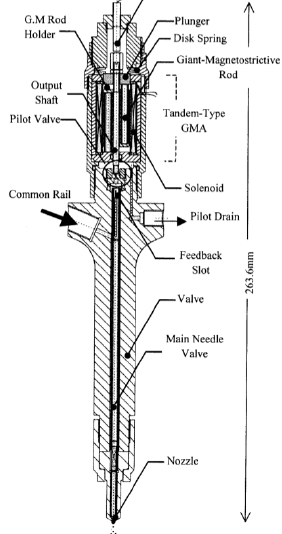
Figure 14. Fuel injector based on a MA, presented in [97]. Reprinted with permission from